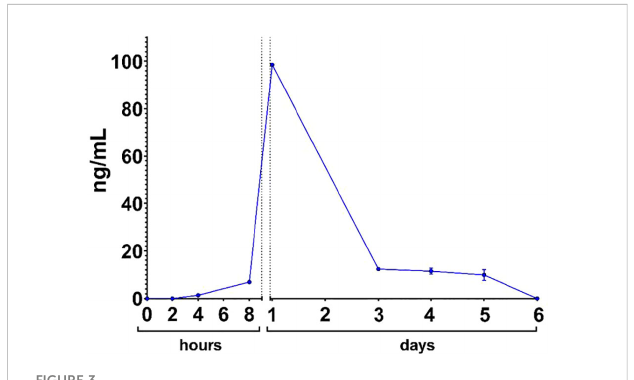
FIGURE 3 B11-Fc antibody serum kinetic after B11-mRNA-LNP administration in